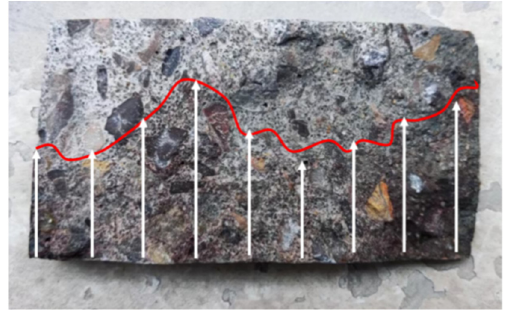
Figure 4. Penetration depth of iodine ions.